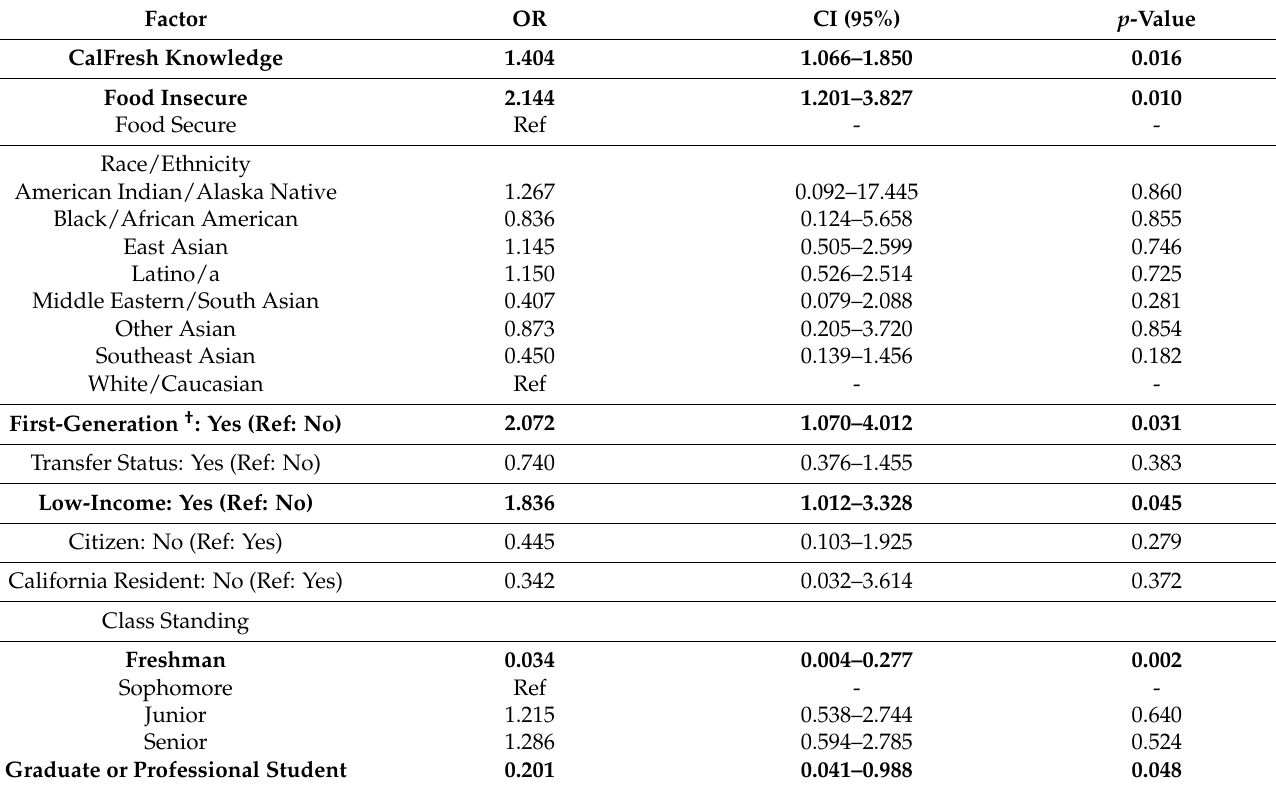
Table 5. Regression Model 2: Logistic Regression of factors examining KAPs Association with CalFresh Participation ( n = 437).